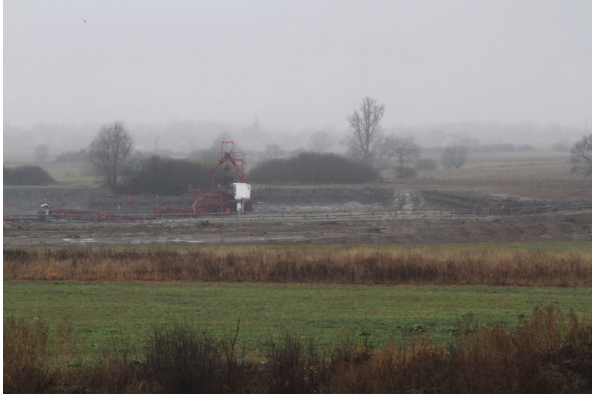
Figure 4: One of gravel mines within the reservoir’s basin, view from the right-bank dam, km